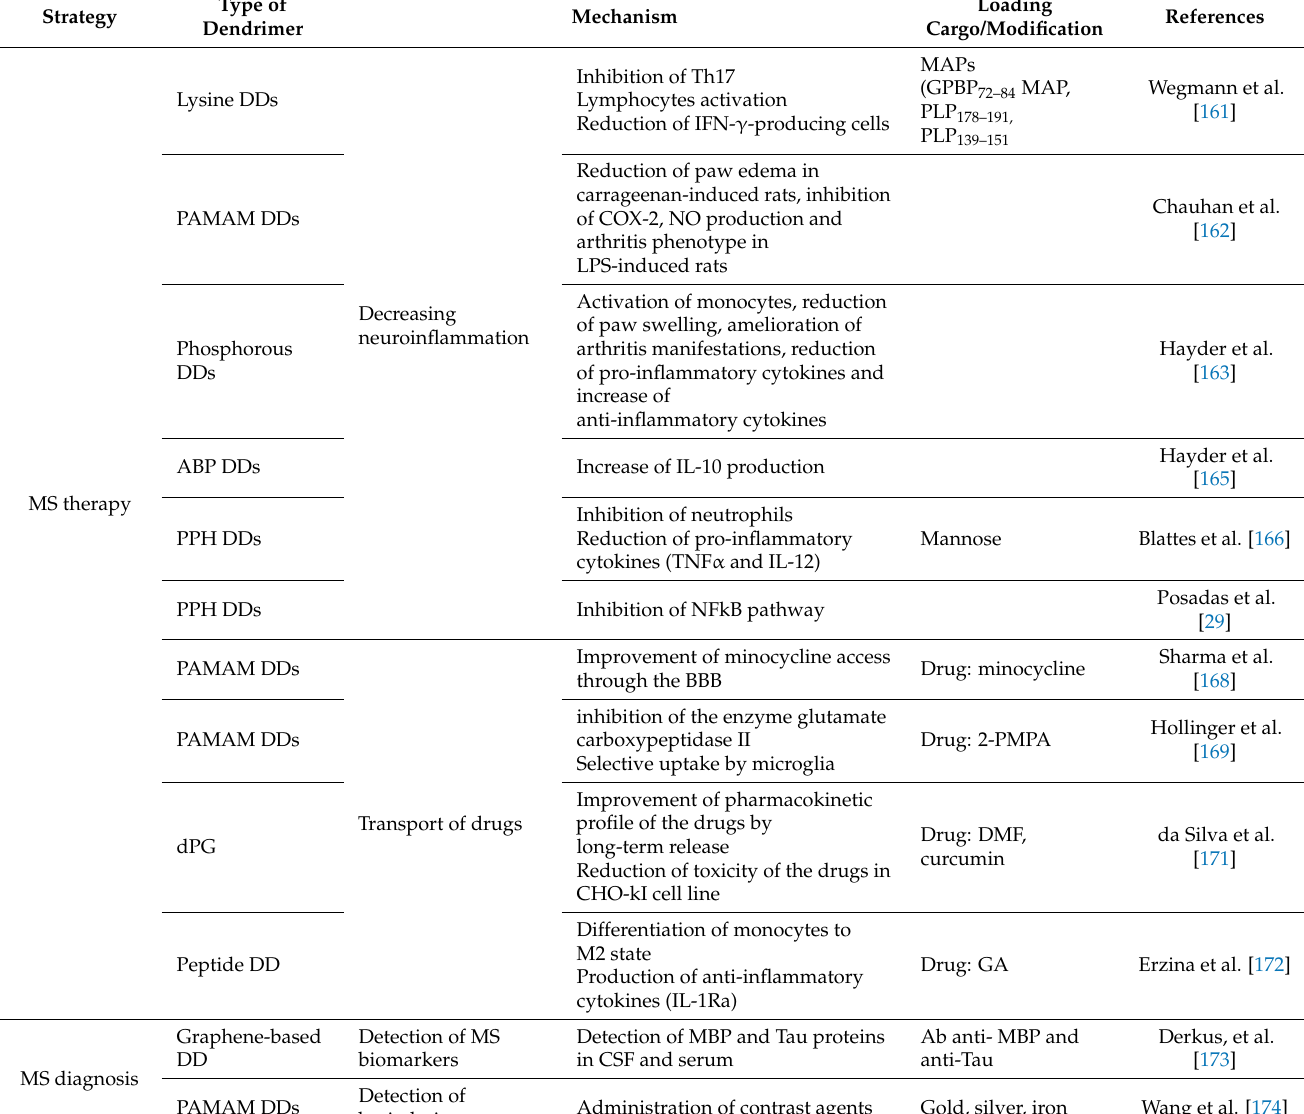
Table 3. DDs for MS therapy and diagnosis: Abbreviations: MAPs (Multiple Ag peptides), GPBP (guinea pig myelin basic protein), ABP (azabisphosphonate), PPH (poly(phosphorhydrazone), BBB (Blood–brain barrier), 2-PMPA (2-(phosphonomethyl)-pentanedioic acid), dPG (dendritic polyglyc- erol, DMF (dimethilfumarate), GA (glatiramer acetate), Ab (antibody), MBP (myelin basic protein)), CSF (cerebrospinal